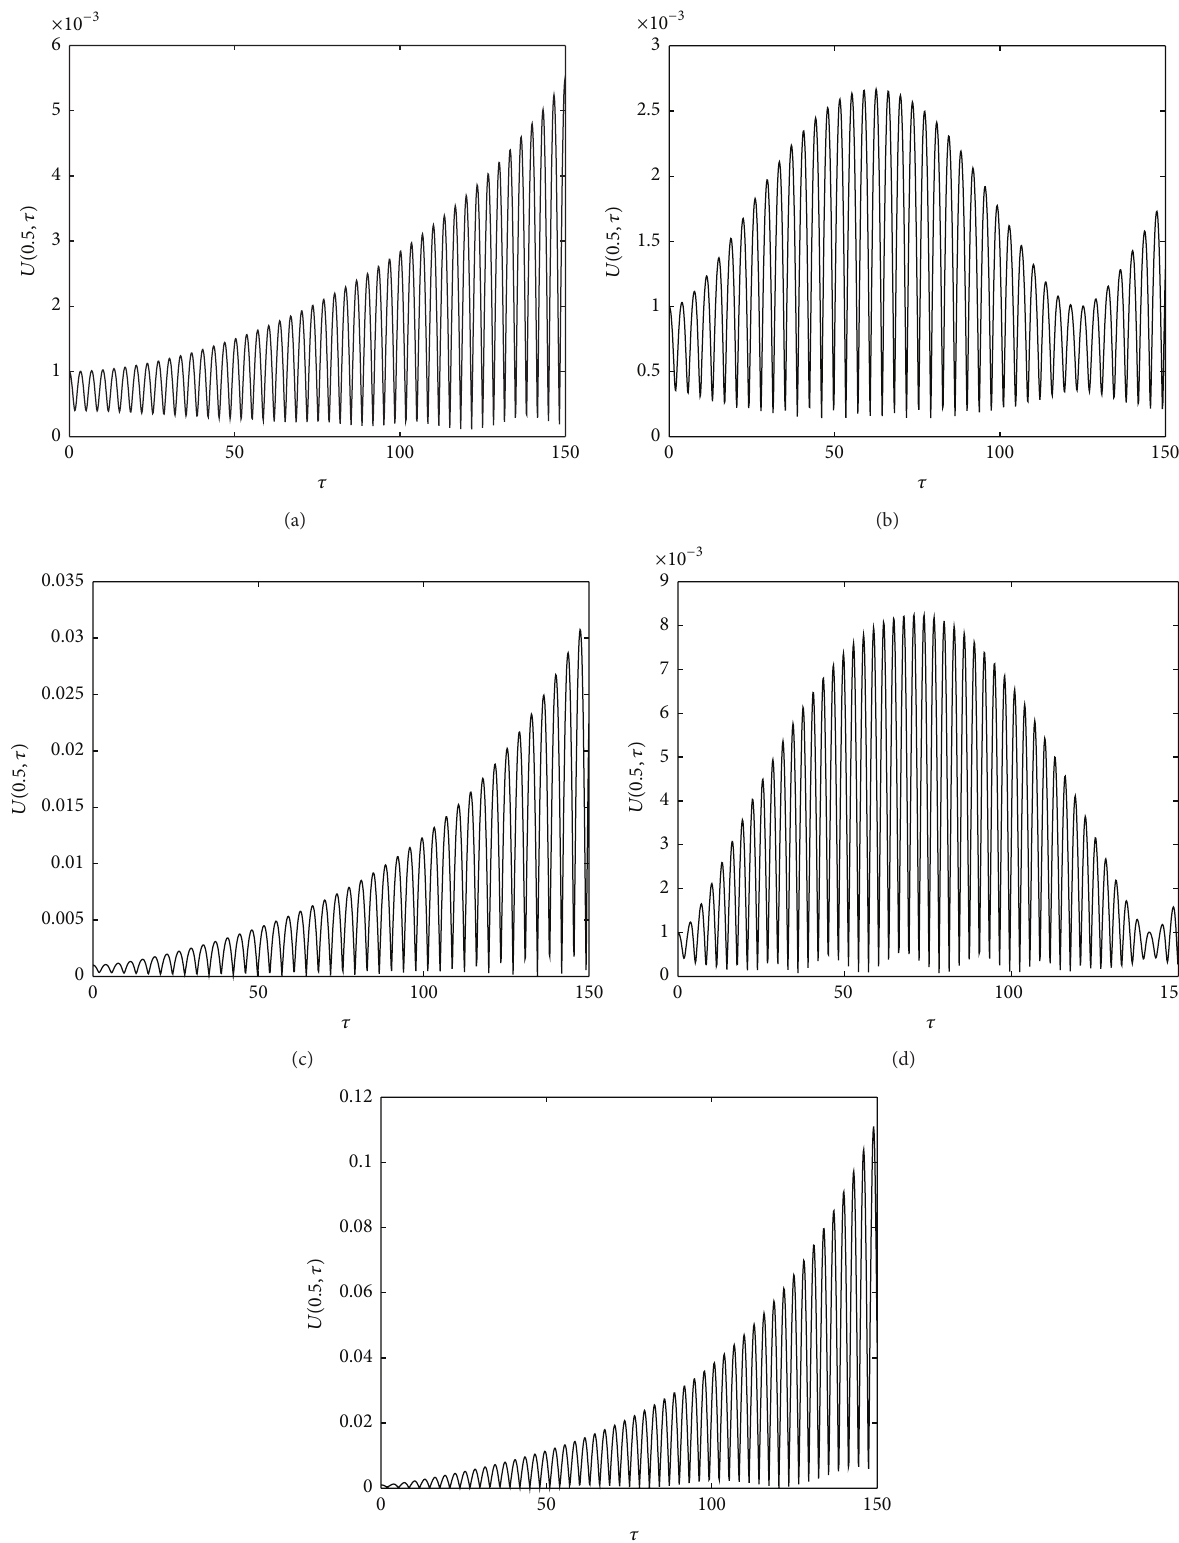
Figure 2: Dynamic responses of transverse displacements with 𝑍 𝑝 = 5 . (a) 𝑍 𝑝 Ω/2𝜔 ∗ = 1.0 𝛽 = 0.05, (b) 𝑍 𝑝 Ω/2𝜔 ∗ = 0.9 𝛽 = 0.34, (c) Ω/2𝜔 ∗ = 0.9 𝛽 = 0.36, (d) 𝑍 Ω/2𝜔 ∗ = 1.1 𝛽 = 0.36, and (e) 𝑍 𝑍 𝑝 𝑝